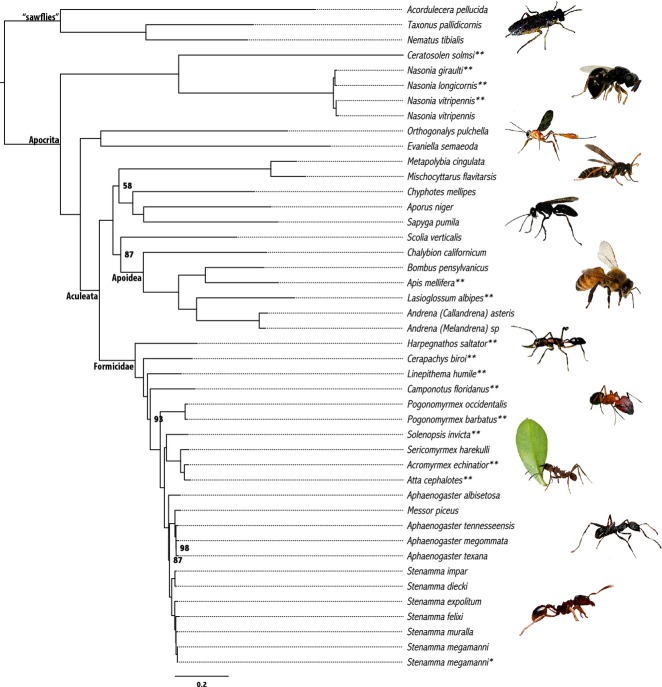
Maximum-likelihood phylogeny inferred from a 75% complete supermatrix containing data from 14 genome-enabled taxa (identified by double-asterisks) and 30 taxa from which we enriched and assembled (Trinity) ultraconserved element loci. We show bootstrap support values only where support is <100%, and the single asterisk beside Stenamma megamanni denotes that this sample represents a different population of the same species.